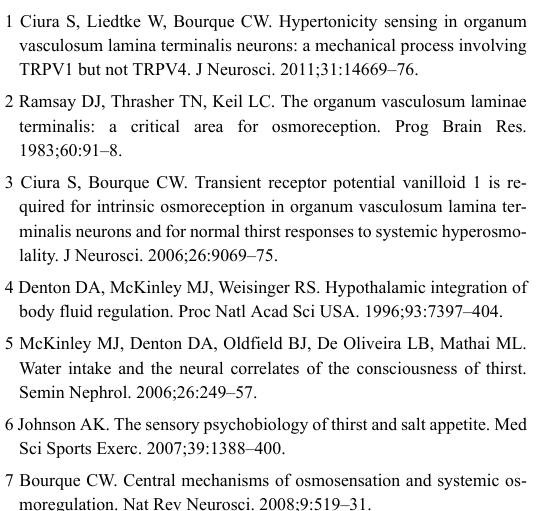
Table 1 Hereditary central and nephrogenic diabetes insipidus ↓ Hereditary central diabetes insipidus Clinical features Polyuria, polydipsia, low urine osmolality during dehydration, increased urine osmolality after desamino-8D-arginine vasopressin (dDAVP) Genetic analysis Mutations in the AVP gene, most are autosomal